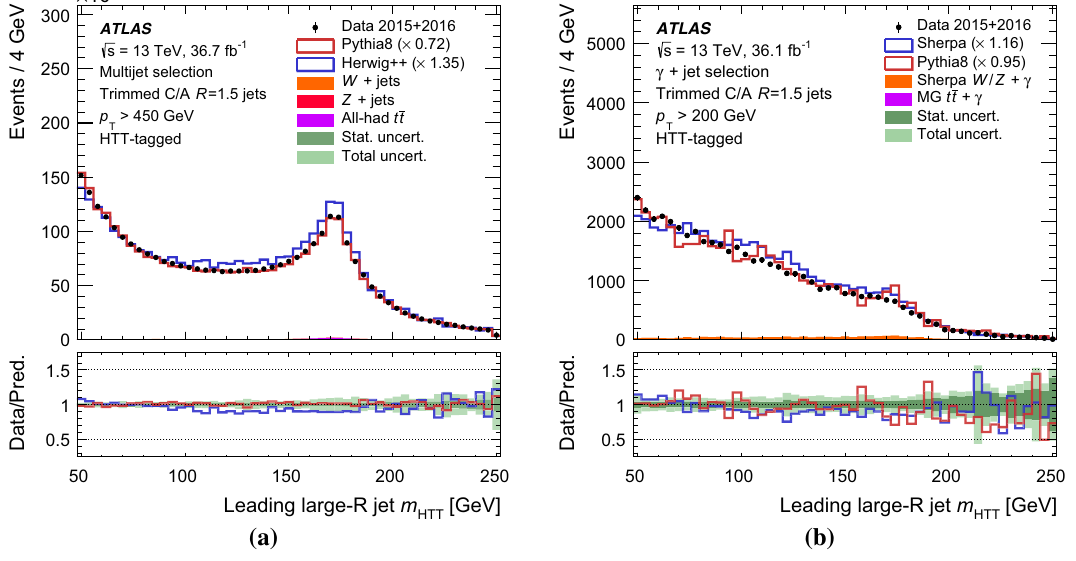
of events, as well as the reconstruction and calibration of the large- R jet. The difference in the shape of the HEPTopTagger mass distribution between the multijet and the γ + jet selections, in particular the absence of a pronounced top-mass peak in the γ + jet selection, is caused by the difference in the jet p T thresholds